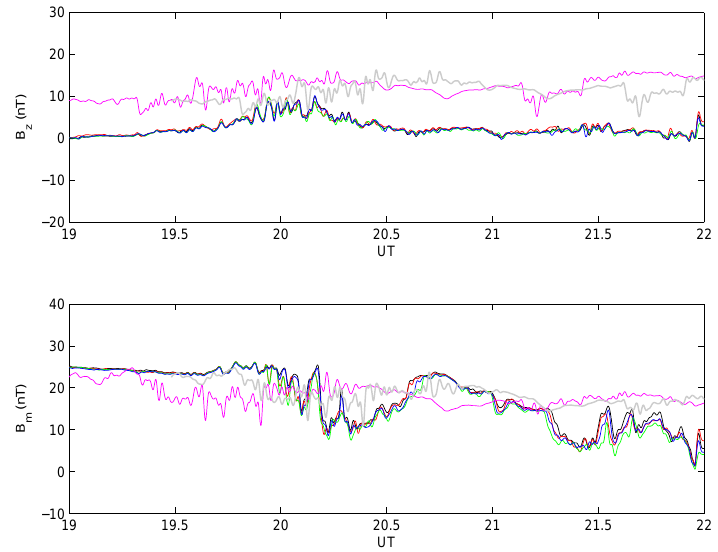
Fig. 3. The low-pass filtered ( τ ≥ 1 . 5min) magnetic field data, B z and B m , for Cluster (usual colours) and TC-1 (solid magenta line). The gray line shows the TC-1 data shifted by